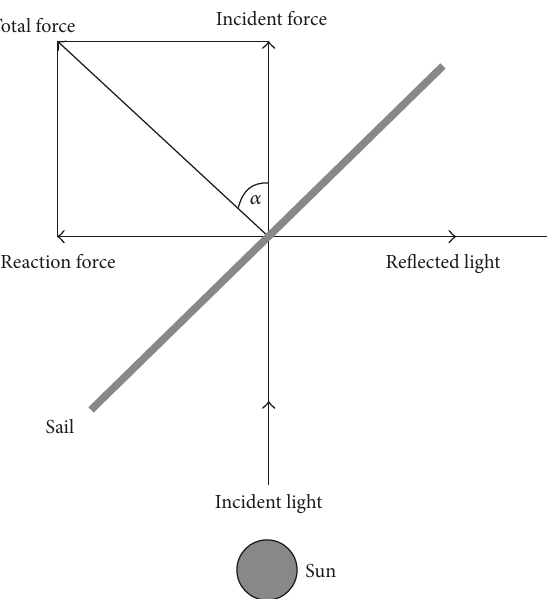
Figure 1: A sketch of the interaction of the solar photons with the